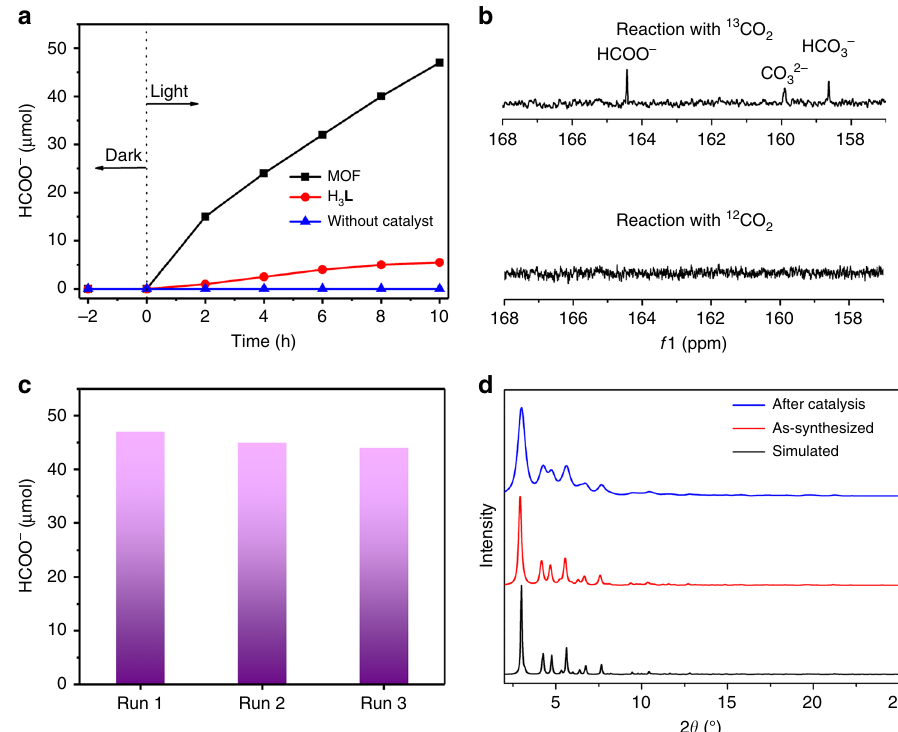
Fig. 3 Photocatalytic CO 2 reduction performance. a Time pro fi les of HCOO − produced catalyzed by Eu-Ru(phen) 3 -MOF or H 3 L or without catalyst under irradiation with a Xe lamp (420 – 800 nm). b The 13 C NMR spectrum of products in liquid phase after reacting with 13 CO 2 and 12 CO 2 , respectively. c The amount of HCOO − produced for reusing three times. Samples were recovered after each cycle and reused under identical reaction conditions. d PXRD patterns for as-synthesized Eu-Ru(phen) 3 -MOF and after photocatalytic reaction, showing its well-retained structure during the